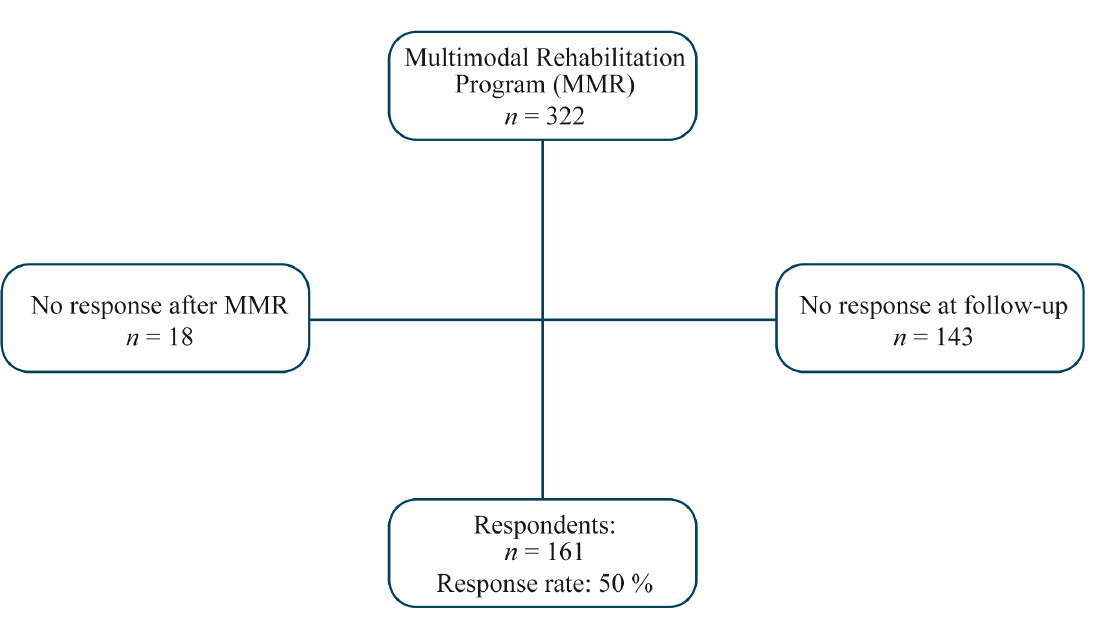
Figure 1. Flow chart. Self-completed questionnaires were given to the patients for them to fill in before, immediately after, and at one-year follow-up after multimodal rehabilitation (MMR). Measures of outcome were: The Short Form health survey (SF-36), Hospital Anxiety and Depression scale (HAD), Numeric Rating Scale (NRS) and interference subscale of Multidimensional Pain Inventory (MPI).